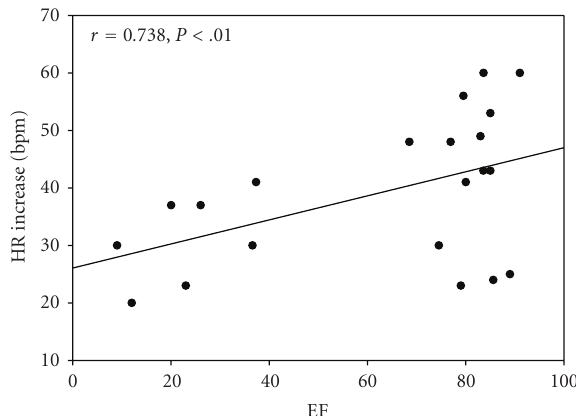
Figure 4: Scatterplot illustrating the relationship between EF and HR increase. EF: Exertion Fatigue, HR: Heart rate, and BPM: beats per minute.